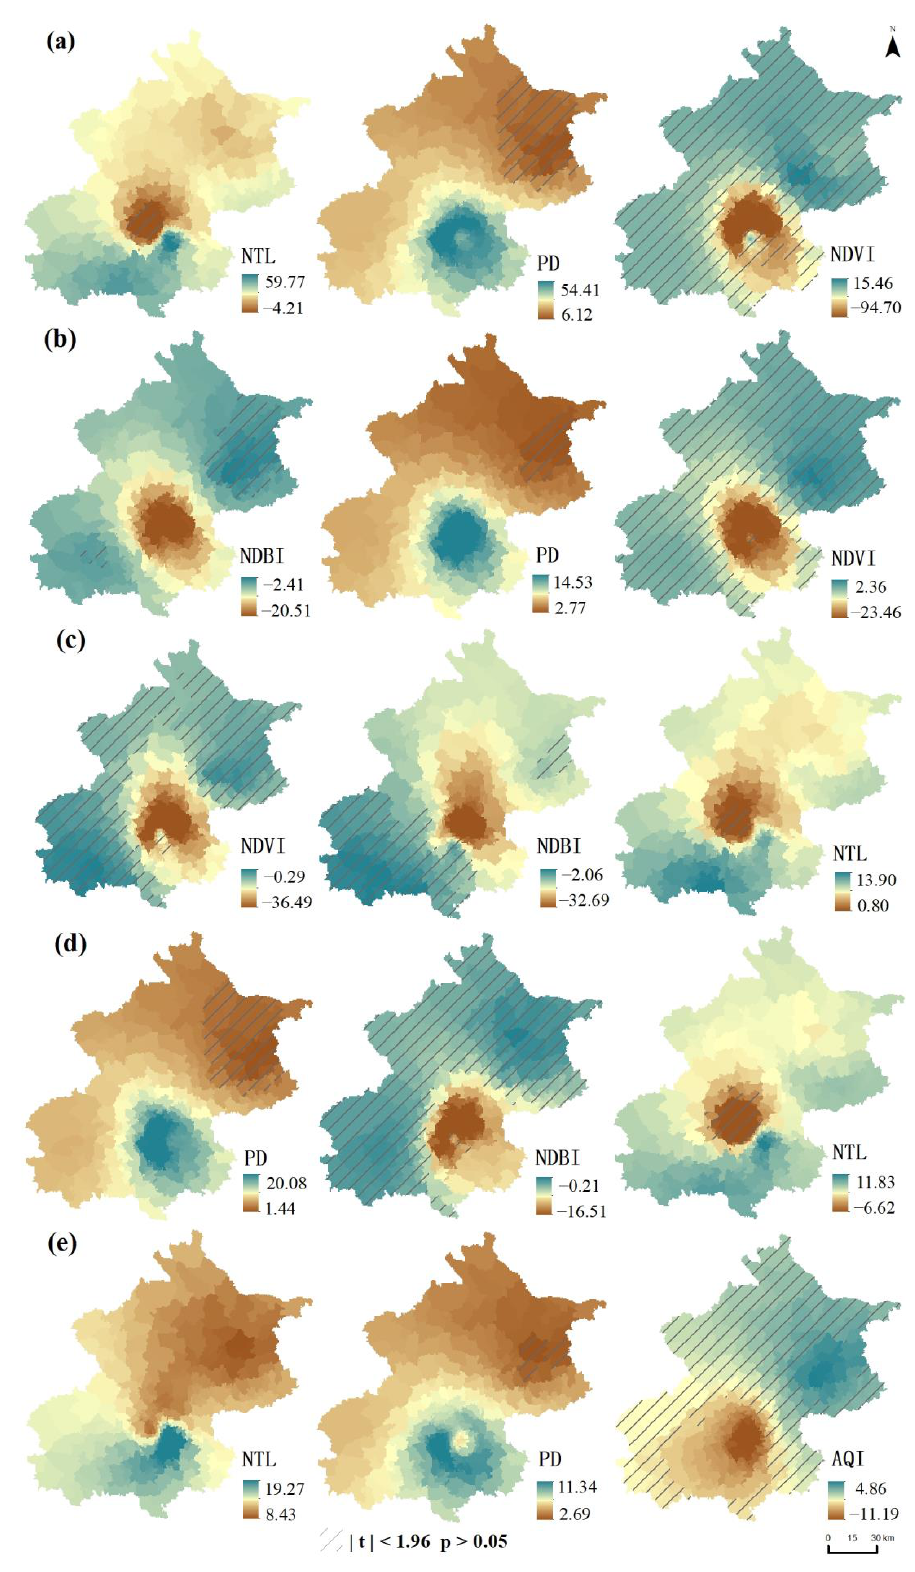
Figure 6. Spatial distribution maps of regression coefficients and significances for each factor in ( a ) Annually, ( b ) Spring, ( c ) Summer, ( d ) Autumn, and ( e ) Winter. Note: population density (PD), nighttime light (NTL), normalized difference vegetation index (NDVI), normalized difference built-up index (NDBI), air quality index